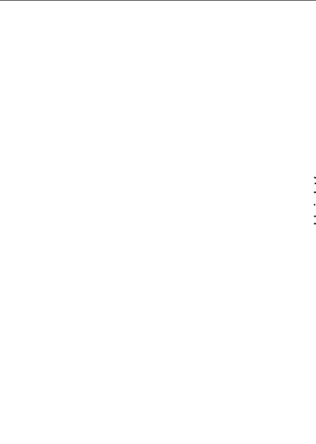
FIGURE 8 | Comparison of simulated and experimental